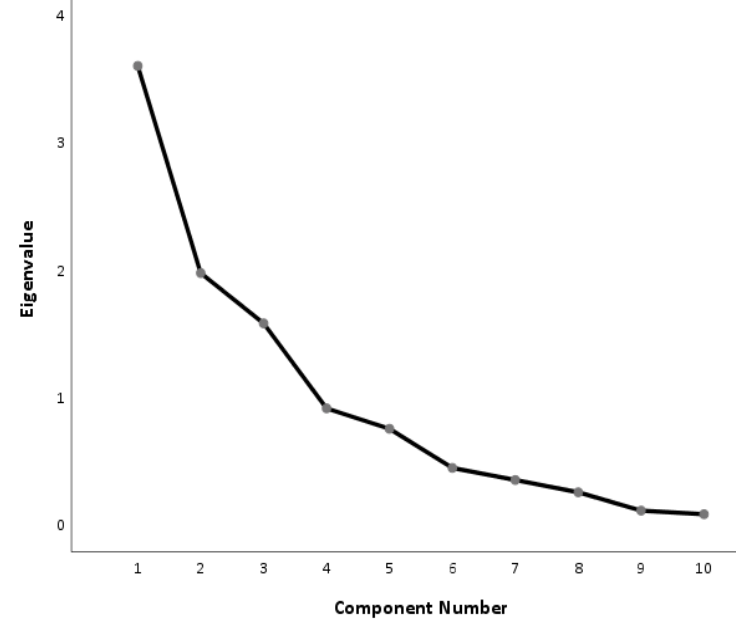
Figure 7. Scree plot of Eigenvalue against component number obtained from PCA.